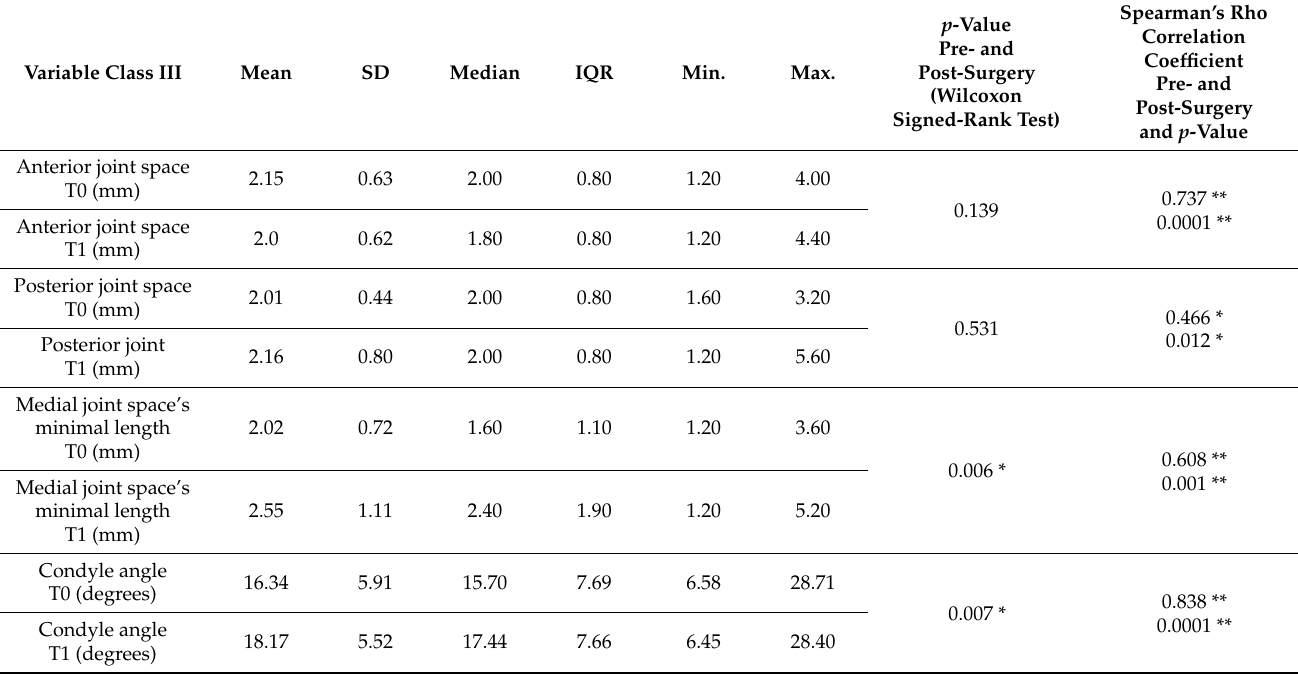
Table 2. Characteristics of the studied variables in the class III malocclusion patients ( n =